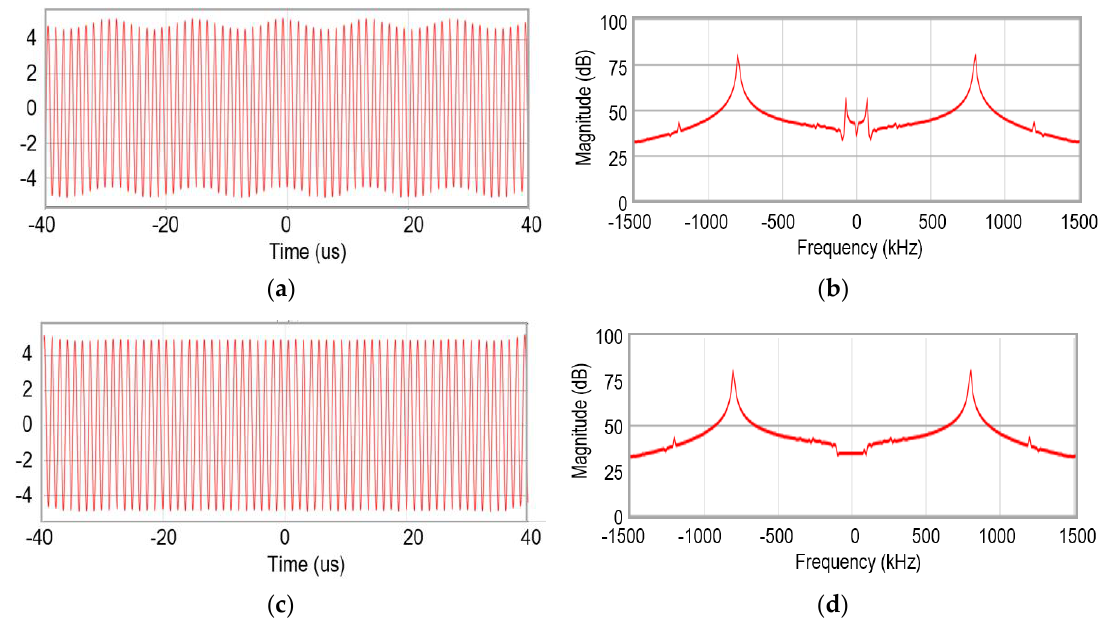
Figure 17. Magnitude of V AB ( a ) in time domain and ( b ) in frequency domain during power transmitting (70 kHz + 800 kHz), and ( c ) in time domain and ( d ) in frequency domain after removing 70 kHz band signals.